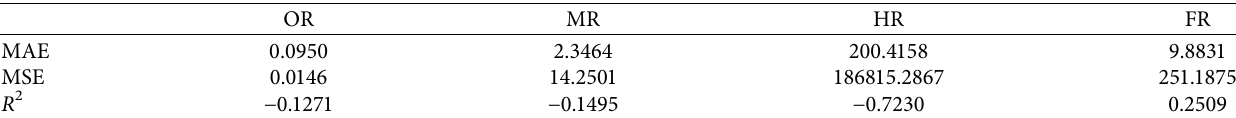
Table 5: Te evaluation metrics of the single